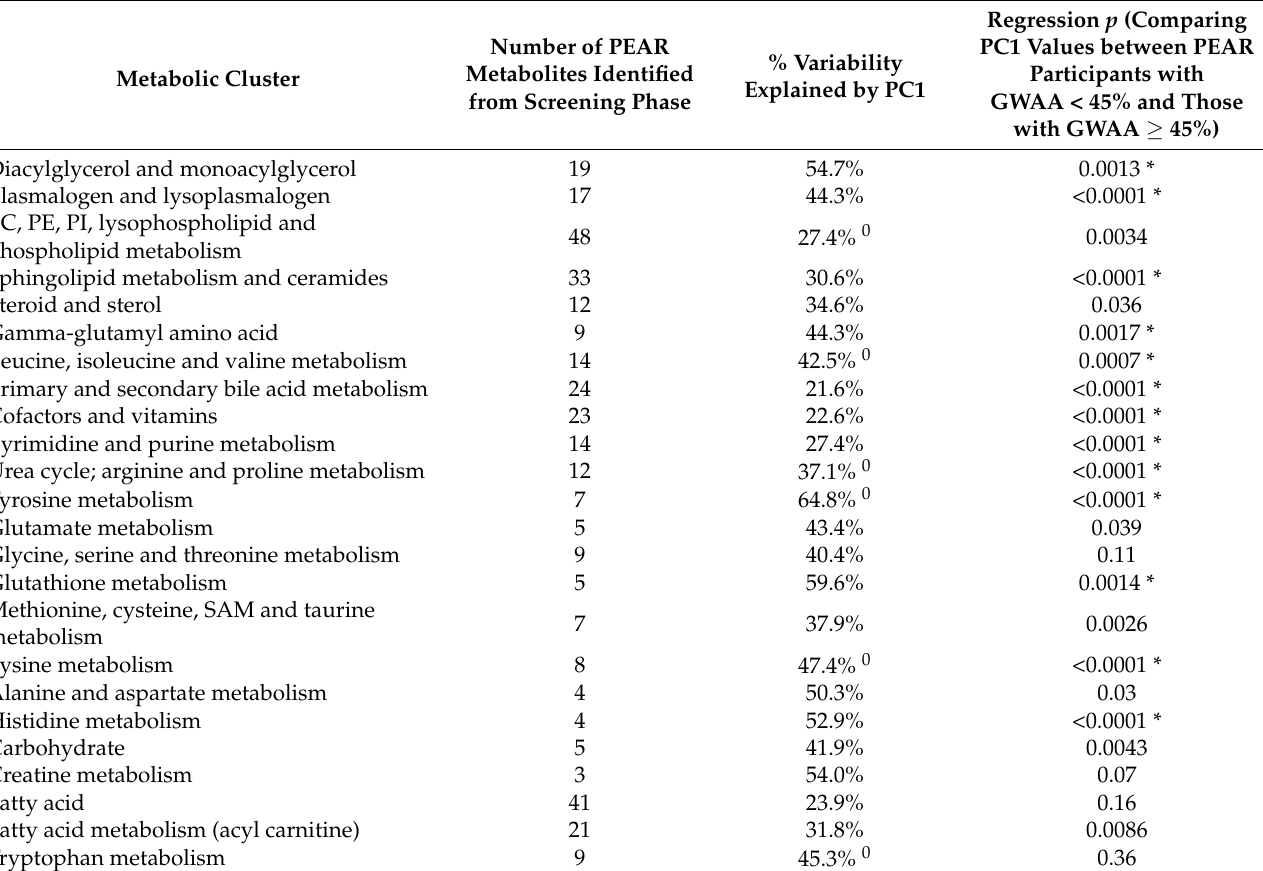
Table 2. Results of the cluster analysis conducted using PEAR discovery cohort on the 24 meta- bolic clusters.